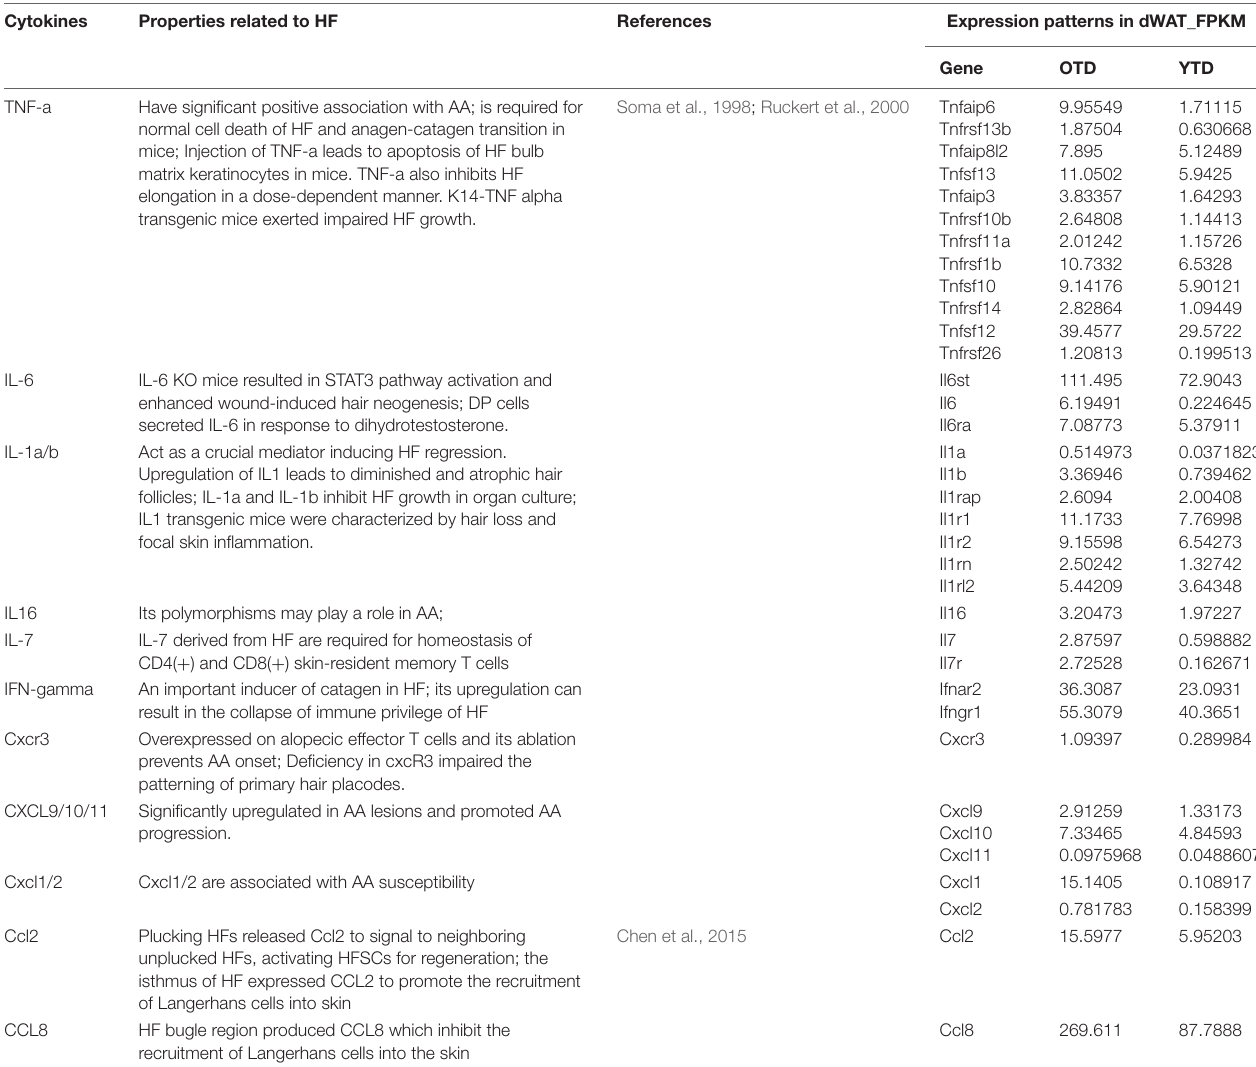
TABLE 1 | | Functional mechanisms of known inflammatory mediators in HF development and specific expression patterns in aging dWAT.